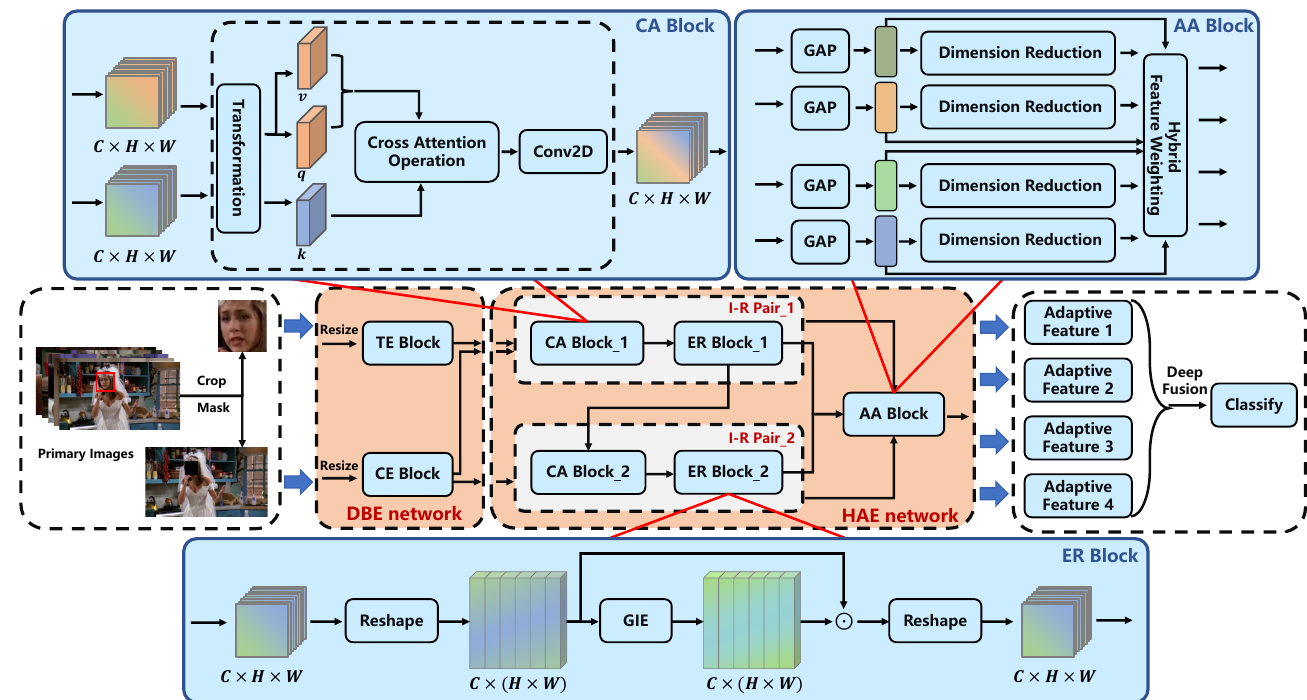
Figure 4. The proposed cross-attention and hybrid feature weighting network (CAHFW-Net) is used for automatic emotion prediction. The dual-branch encoding (DBE) network is constructed with target encoding (TE) (dealing with facial regions) and context encoding (CE) blocks, by which a pair of face-context images can be encoded into respective shallow representations. C , H and W denote the number of channels, the height, and width of the input tensor, respectively. (cid:12) refers to element-wise multiplication. I-R denotes the interaction–rectification pair constructed with cross-attention (CA) and element recalibration (ER) blocks. The adaptive-attention (AA) block is used to find the optimal fusion weights for feature integration. GIE refers to Global Information Extraction. GAP and Conv2D denote the global average pooling and two-dimensional convolution layer. The loss function for the CAHFW-Net is cross-entropy (CE), as shown in Equation